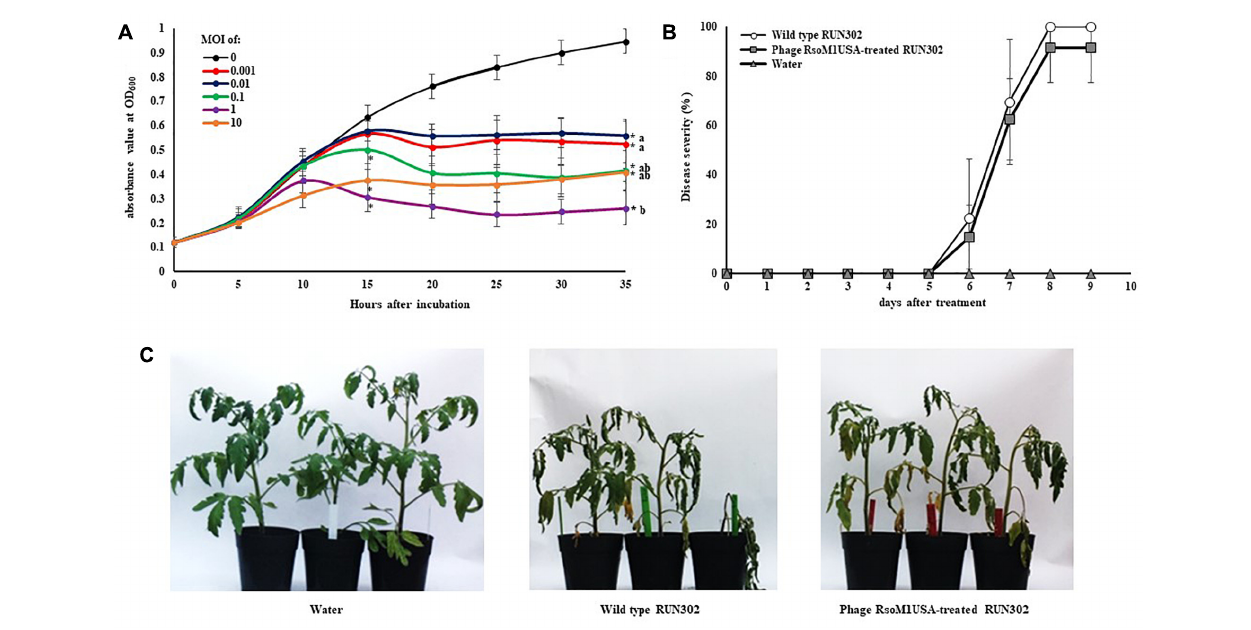
FIGURE 6 | Effects of Ralstonia phage RsoM1USA on R. solanacearum strain RUN302. (A) In vitro growth of R. solanacearum strain RUN302 inoculated with phage RsoM1USA at a multiplicity of infection (MOI) of 0 (black), 0.001 (red), 0.01 (blue), 0.1 (green), 1 (pink) and 10 (orange), respectively. Bacterial growth indicated by absorbance at 600 nm was measured every 60 min and graphed every 5 h for 35 h. Points shown are the means of three separate experiments, each containing three replicates for each MOI treatment. Bars indicate standard errors. ∗ indicates significant difference ( p < 0.05) at hours 15 and 35 between MOI of 0 and each of the other MOIs by the t -test. Means with different letters at hour 35 are significantly different based on the Tukey’s Honest Significant Difference test ( p < 0.05). (B) Virulence of R. solanacearum strain RUN302 alone (open circle) and co-inoculated with phage RsoM1USA at the MOI of 0.1 (closed square). Disease severity was calculated based on a 0 (healthy) to 4 (75 to 100% leaves wilted) disease index of each plant. Points shown are means of three separate experiments, each containing 12 plants per treatment. Bars indicate standard errors. Significance of means was measured using the t -test ( p < 0.05). (C) Appearance of the inoculated plants 8 days after soil drenching inoculation with water (left), RUN302 (middle), or RUN302 followed by phage RsoM1USA at the MOI of 0.1